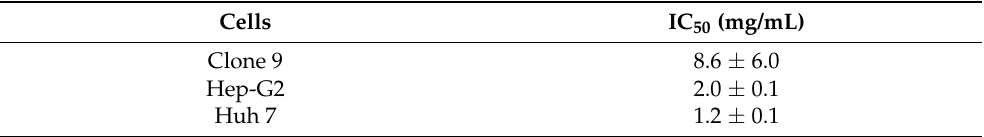
Table 1. IC 50 values for tagitinin C in normal cell lines (Clone 9) and hepatoma cell lines (Hep-G2 and Huh 7) after 24 h of treatment.